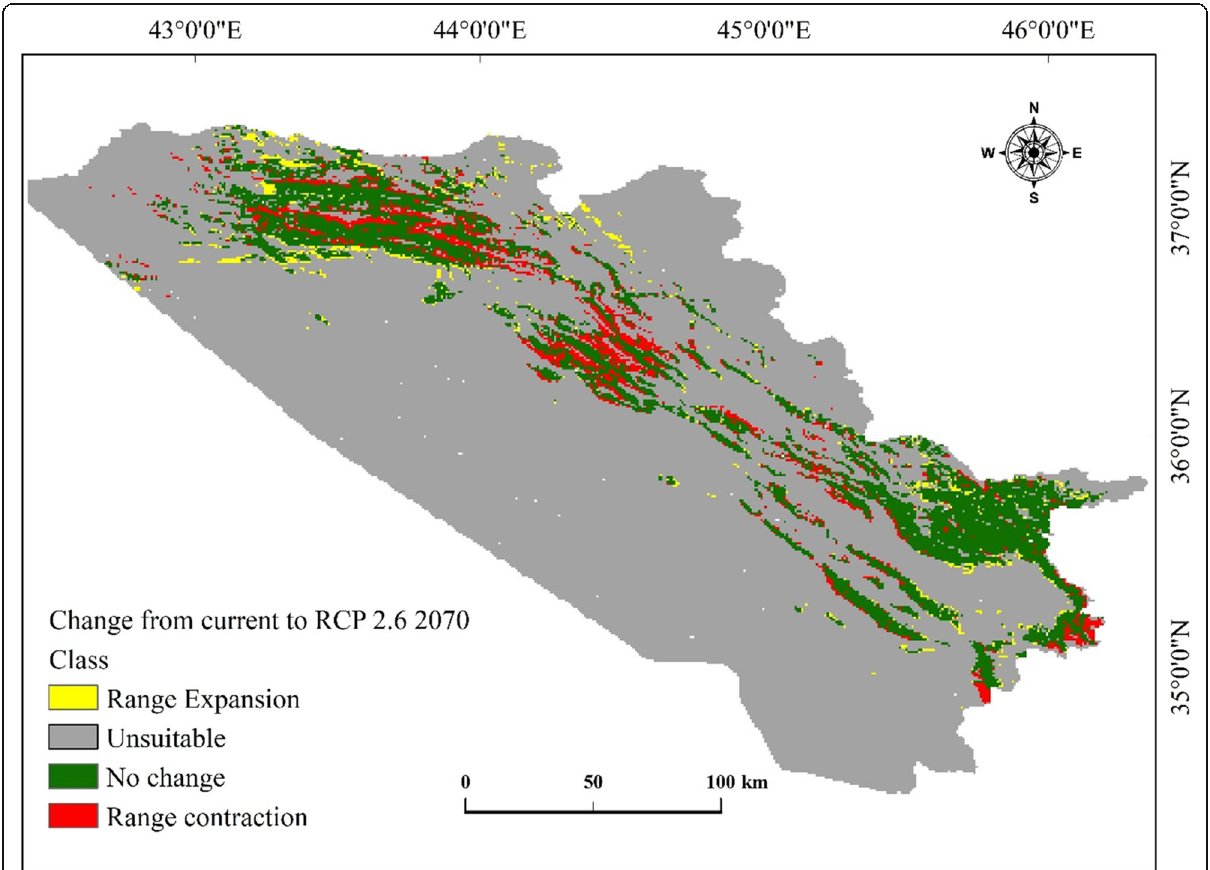
Fig. 5 Difference between the current distribution and future distribution under the RCP 2.6 2070 climate change